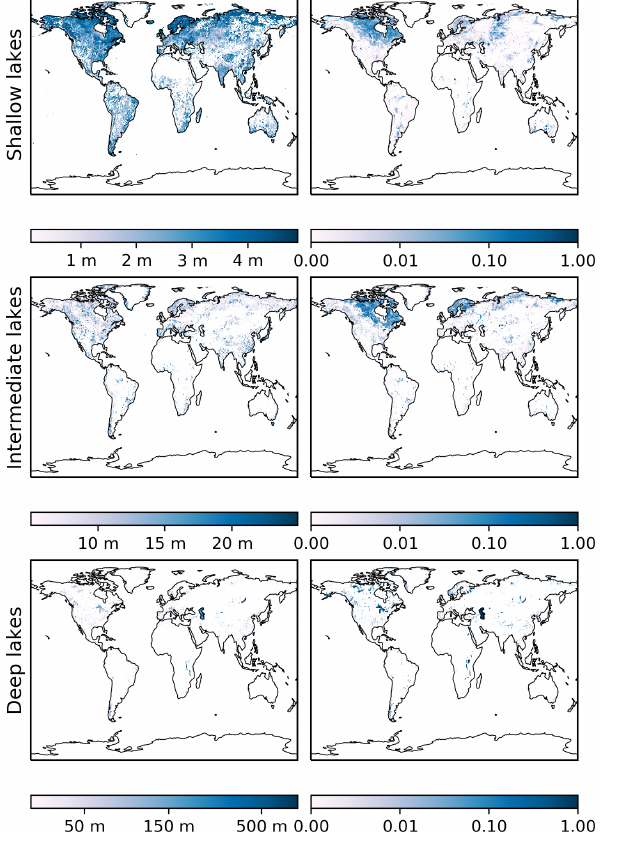
Figure 2. Lake depth (left column) averaged for each lake cate- gories: shallow (below 5m), intermediate (between 5 and 25m) and deep (above 25m), and cover fractions (right column) at a spatial resolution of 0.5 ◦